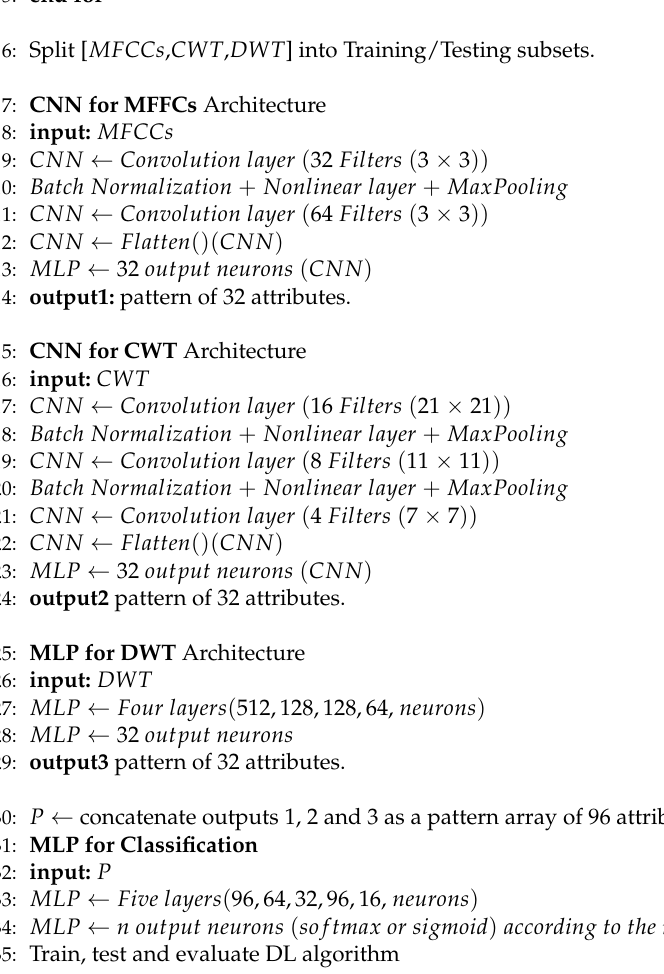
Algorithm A4 DL